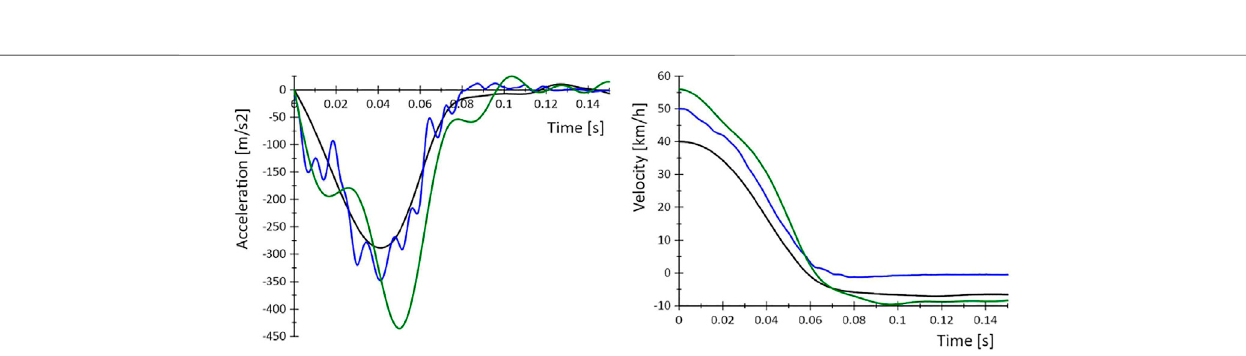
FIGURE 3 | Left: acceleration vs. time. Right: velocity vs. time. For both fi gures, the black curves represent the low-severity crash pulse (40 km/h), the blue curves represent the mid-severity crash pulse (50 km/h), and the green curves represent the high-severity crash pulse (56 km/h).